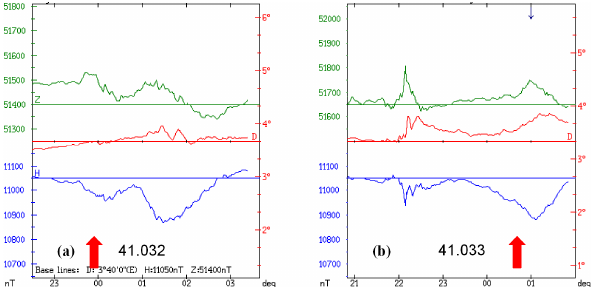
Fig. 5. Magnetogram records for the launch times of Flights 41.032 (1 July 2002, 23:56 UT) and 41.033 (5 July 2002, 00:47 UT) from Andøya, Norway.